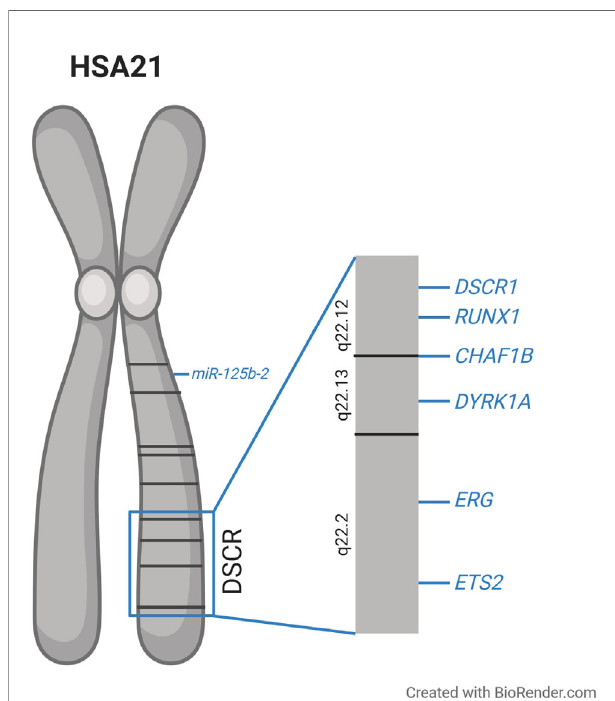
FIGURE 1 | Schematic overview of human chromosome 21 (HSA21) and the proposed Down syndrome critical region (DSCR), along with the location of the genes discussed in this article which are suggested to be involved in the dysregulated hematopoiesis observed in individuals with trisomy